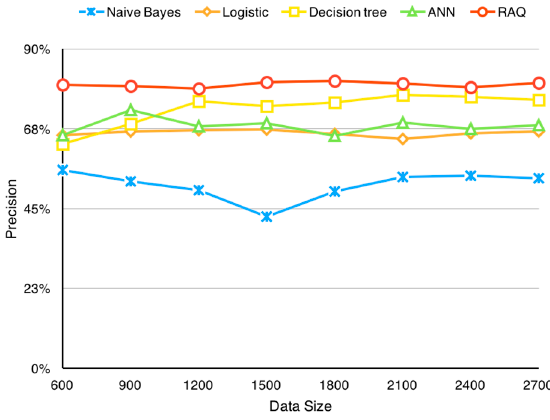
Figure 12. Precision changes according to data size.